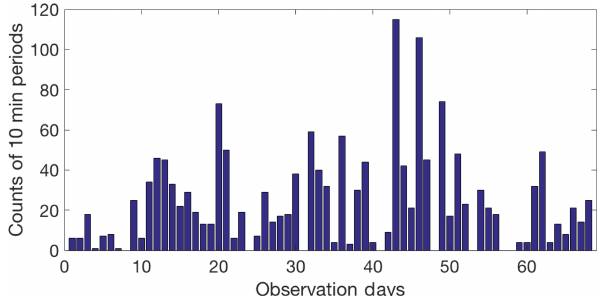
Figure 3. Distribution of the 1613 available 10min periods with wind directions perpendicular to the ridges (214–254 and 34–74 ◦